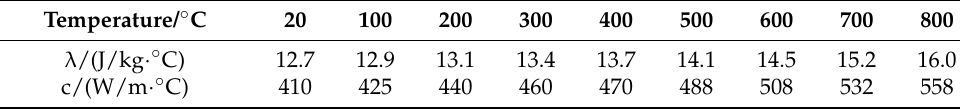
Table 2. Thermal physical parameters of Ni60 alloy